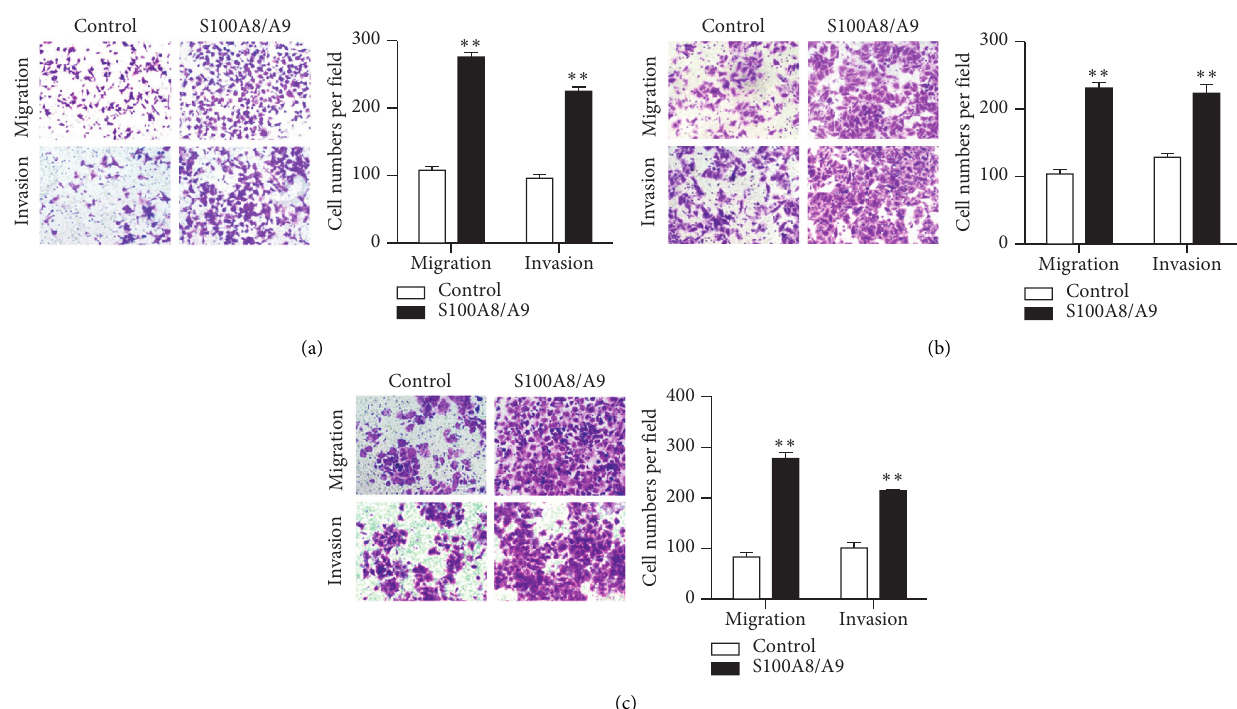
Figure 2: Effects of exogenous S100A8/A9 stimulation on the cell migration and invasion of NPC cells including CNE1, CNE2, and 6-10B. The lower chamber was filled culture medium with or without S100A8/A9 proteins (1 μ g/ml) to explore the migration and invasion abilities of NPC cells including (a) CNE1, (b) CNE2, and (c) 6-10B. The left panels are representative images and right panels are quantifications. n � 3, ∗∗ P < 0 .